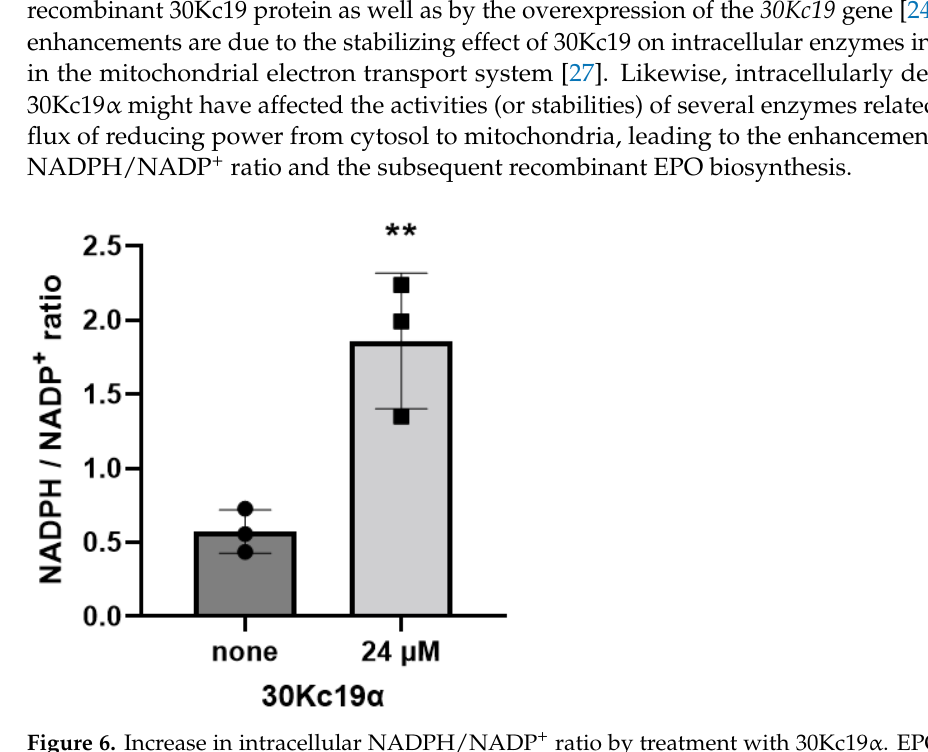
Figure 6. Increase in intracellular NADPH/NADP + ratio by treatment with 30Kc19 α . EPO–CHO cells were dually treated with 24 µ M 30Kc19 α , and subsequently collected on day 3 of culture in serum-free medium. The concentration of intracellular NADPH and NADP + were determined using an NADP/NADPH assay kit. Error bars indicate standard deviations ( n = 3 per group). Statistical significance was determined between nontreated control and 30Kc19 α -treated cells using Student’s t -test. **, p < 0.01 compared to the non-treated control.